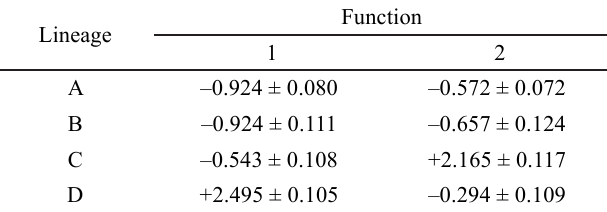
Table 5. Standardized coefficients of the two discriminant func